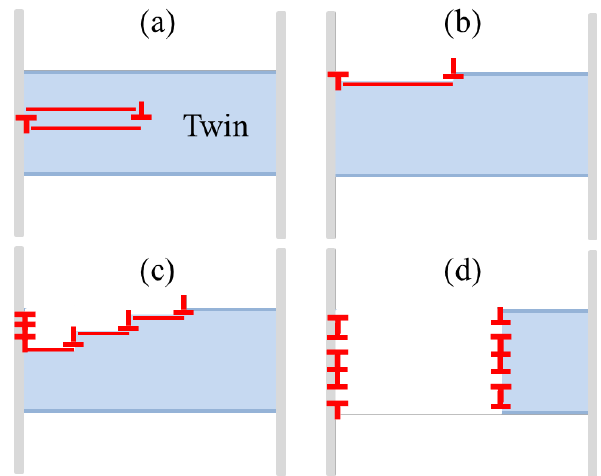
Figure 4(d) is the grain size distribution of bimodal Cu before (black line) and after (red line) tensile test. The red line shifts toward left to the black line, especially in the grain size range larger than 1 µm ( i.e. the grain size of recrystallized micro-grains), and keeps nearly unchanged in the UFG region. These observations indicate that grain refinement occurred in micro-grains and the UFGs remain unchanged. During tensile deformation, the micro-grains burdened most of the strain and were severely deformed and elongated along the tensile axis. Dislocation activity including gliding, propagation, tangling and interaction plays a dominant role in the deformation of CGs because CGs provide adequate spacing for significant numbers of dislocation intersections during deformation. The UFGs retained more or less equiaxed shape (Figure 4a), so that the grain size measurement in Figure 4(e) is convincing. Figure 4(e) plots the grain boundary misorientation angle distribution of bimodal Cu before (black line) and after (red line) tensile test. In the first place, the fraction of low angle (especially < 5 ∘ ) grain boundary after tensile test is much larger than its counterpart. This phenomenon is related to dislocation multiplication and the formation of subgrain referred in Figure 4(b). Besides, at the 60 ∘ misori- entation angle (denoting twins in cubic metals and alloys), the fraction decreases from 20% (before tensile test) to 6% (after tensile test). The reduction means detwinning hap- pened in these micro-grains during tensile test.